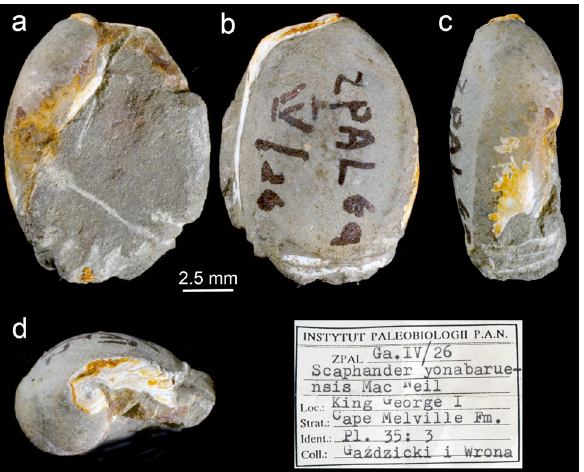
Figure 4. Images of the single fossil of Philinoidea found in Antarctica (King George Island) dated from the Lower Miocene and originally attributed to the Japanese Scaphander yonabaruensis Mac Neil, 1960 (Karczewski, 1987), but here redesignated to Antarctophilinidae. ( a ) Ventral view. ( b ) Dorsal view. ( c ) Lateral view. ( d ) Apical